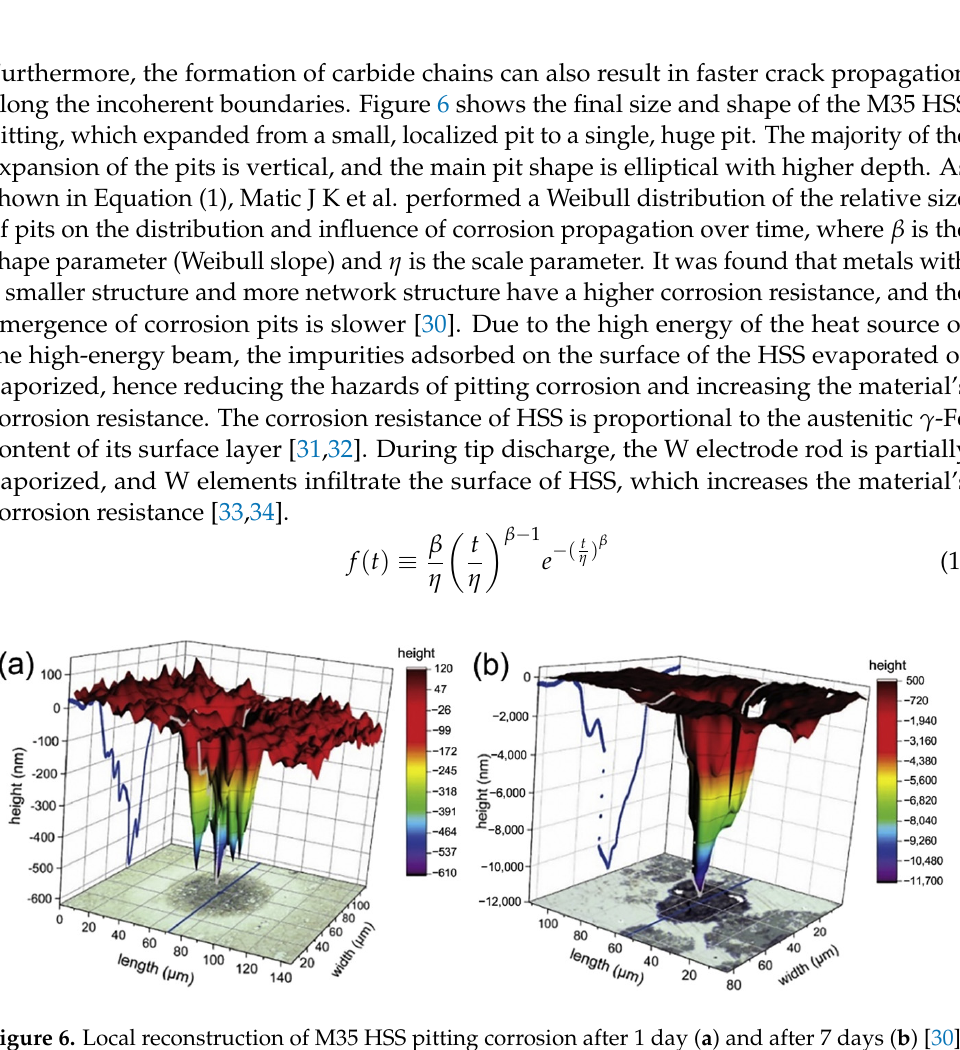
Figure 6. Local reconstruction of M35 HSS pitting corrosion after 1 day ( a ) and after 7 days ( b ) [30]. Kwok C T et al. [35] carried out laser remelting on the surfaces of M2, ASP23, and ASP30 HSS, and discovered that the corrosion current density was decreased and the corrosion resistance of HSS was strengthened. The combined effect of refinement of bulky carbides in the HSS microstructure and higher solubility of passivating alloys in austenite and martensite, as a result of laser remelting, enhanced the corrosion resistance of HSS, with ASP-23 HSS exhibiting the highest corrosion resistance after laser remelting. Optical images of cross-sectional appearance and the SEM images of the melting zone (MZ)of the laser-melted specimens (LMS) are shown in Figure